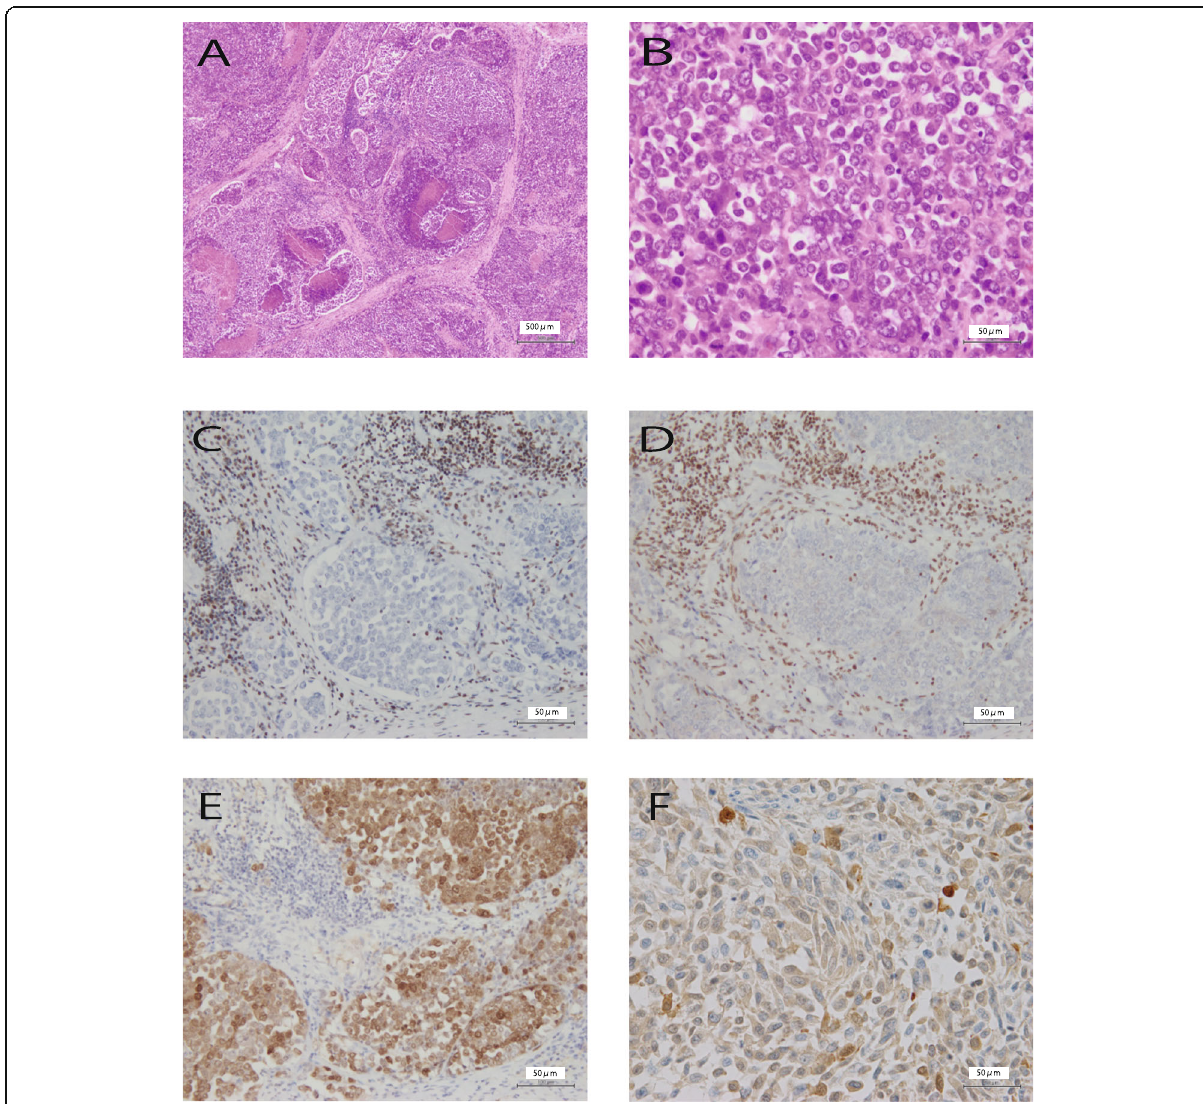
Fig. 2 Representative histological findings and immunohistochemical features of SMARCA4-deficient carcinoma in the present case. A Necrotic and sheet-like growth pattern of monotonous epithelial-like cells. B The loose-binding tumor cells have distinct nucleoli. Rhabdoid-like cells are also observed. C Little or no immunoreactivity with anti-SMARCA4 antibodies. D Little or no immunoreactivity with anti-SMARCA2 antibodies. E Positive SOX2 immunoreactivity. F Weakly diffuse positive AE1/AE3